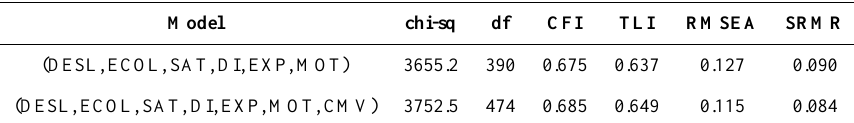
Table 3. Testing for Common Method Bias (n =